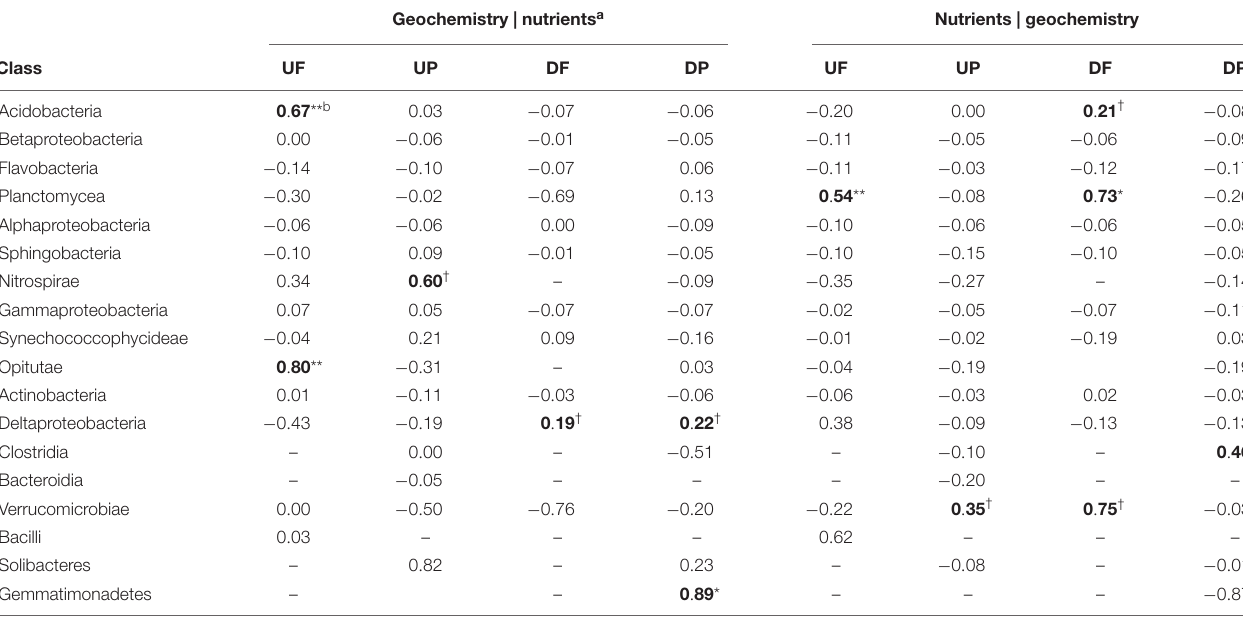
TABLE 2 | The partial Mantel test to reveal environmental parameters that are correlated with class-level sub-network topology. Geochemistry | nutrients